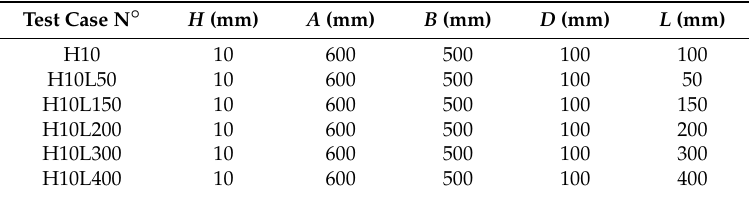
Table 1. Size of the configuration.